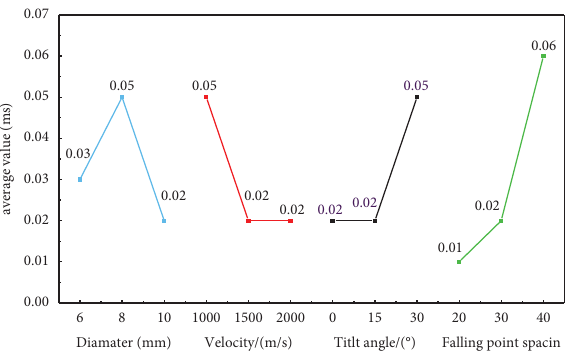
Figure 12: Infuence of various factors on the occurrence time of surface